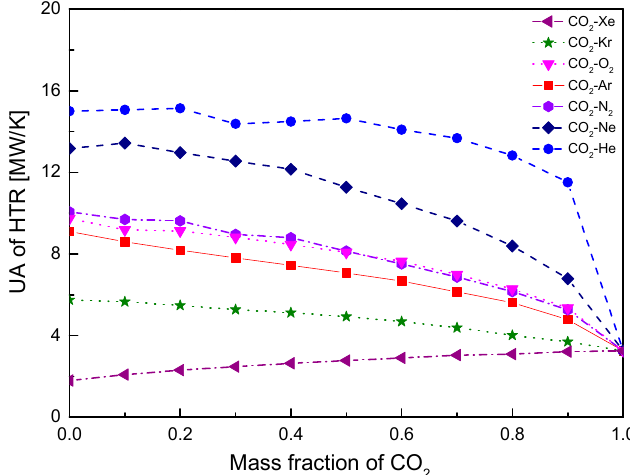
ff erent mass fractions of CO 2